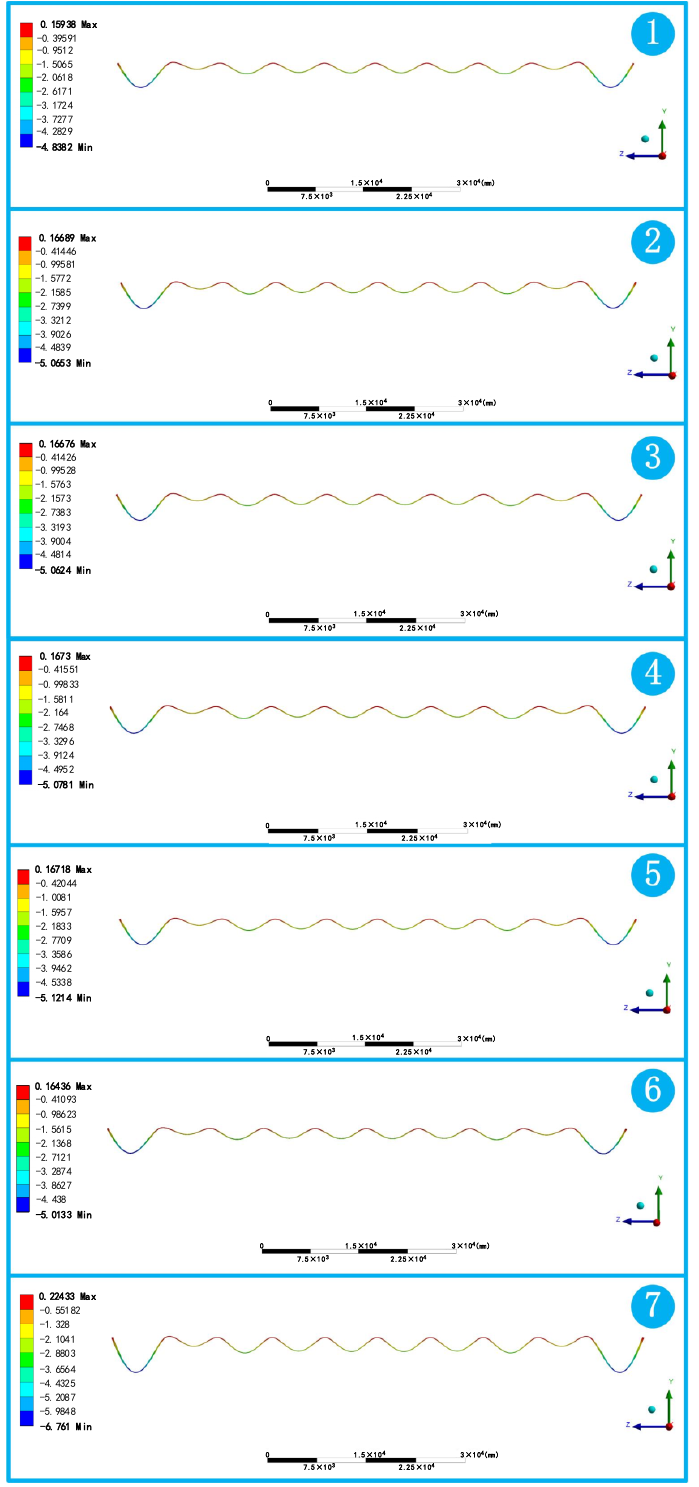
Figure 7. Static deflections of multi-span conductor rail. No. 1 – 6 denote the results of new types of conductor rail with large moment of inertia, and the result of the conventional one is denoted as No. 7.